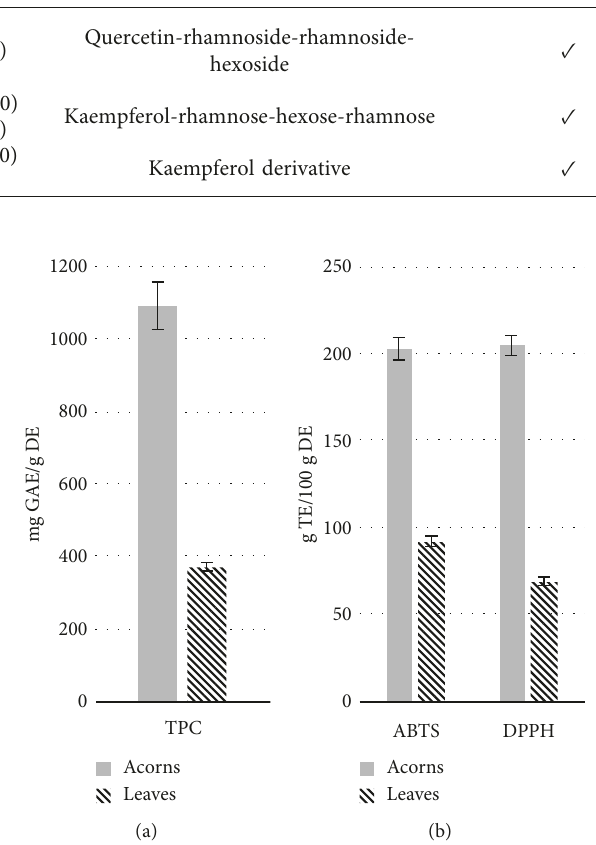
Figure 2: TPC, ABTS, and DPPH results for acorns and leaves of methanol extracts of Q. coccifera . GAE: gallic acid equivalents; TE : Trolox equivalents; DE: dried